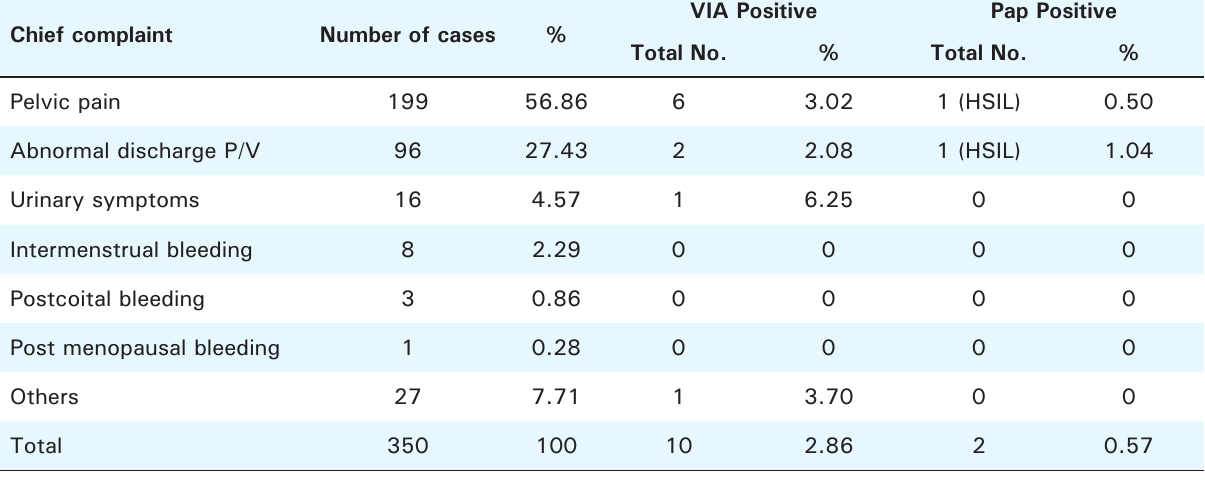
table 3. screening results in relation to chief Presenting